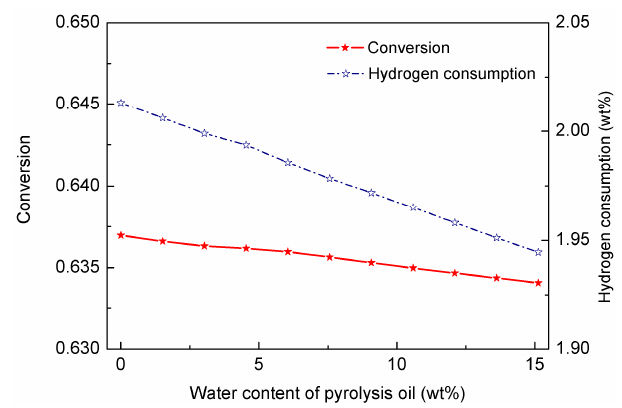
Figure 13. E ff ects of water content on conversion and hydrogen consumption. Figure 13. Effects of water content on conversion and hydrogen consumption.